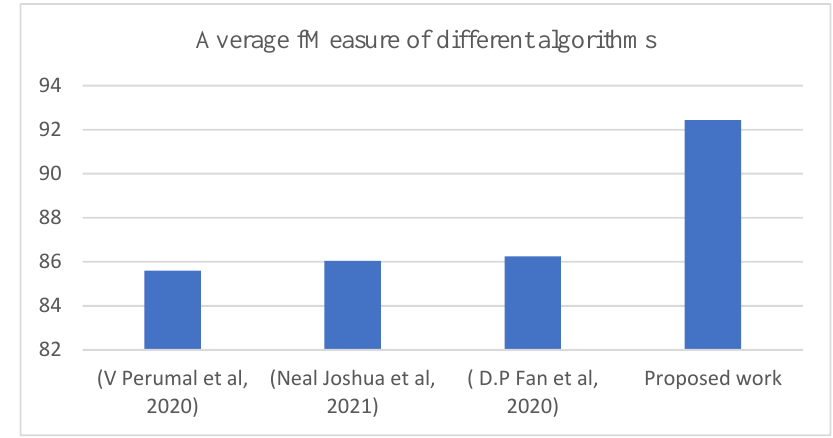
Figure 14. Average fMeasure for different algorithms from [7,19,28], and proposed